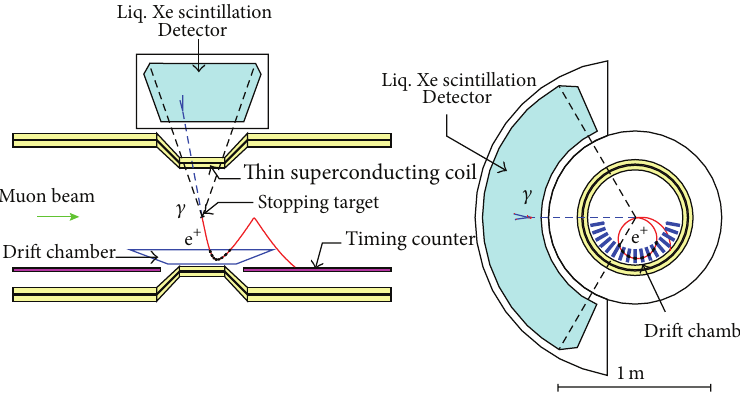
Figure 14: Layout of the MEG